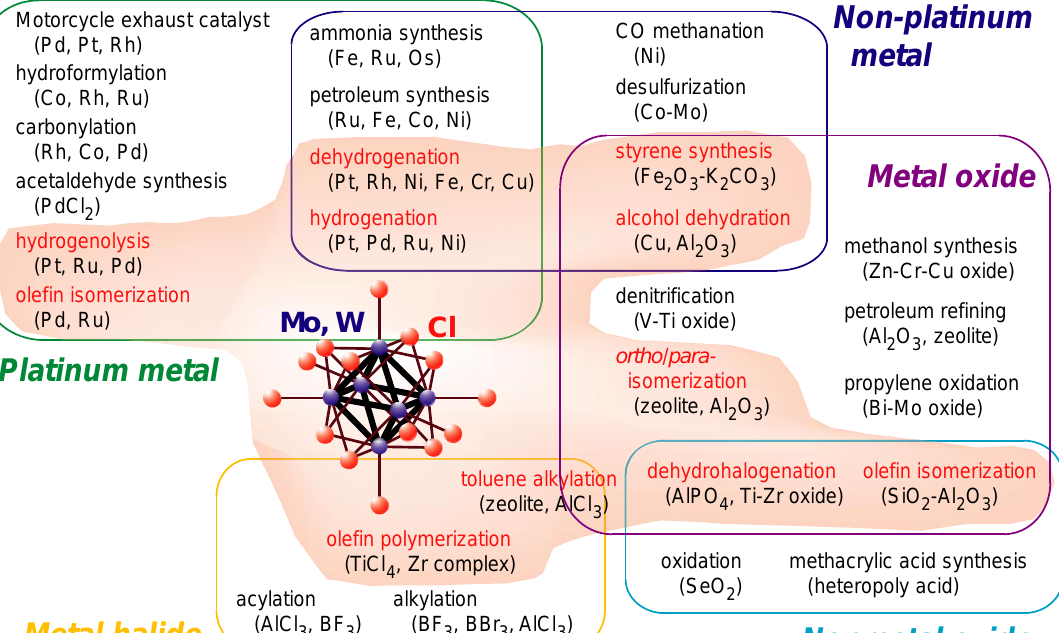
Figure 36. Reactions catalyzed by halide